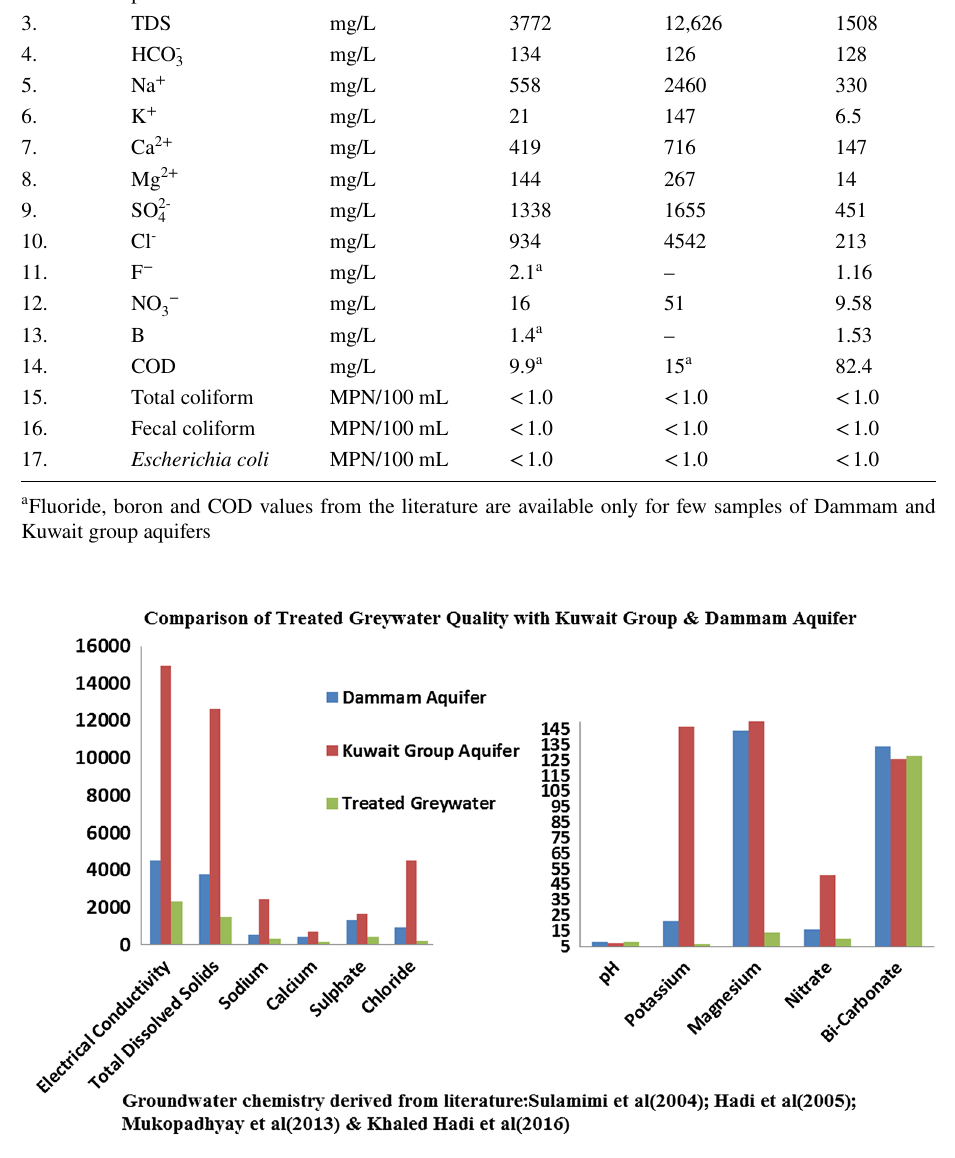
Table 6 Comparison of treated greywater quality with Kuwait group and Dammam aquifer literature (Sulami and Al Ruwaih 2004; Hadi and Al-Ruwaih 2005; Mukhopadhyay et al. 2012; Hadi et al. 2016)